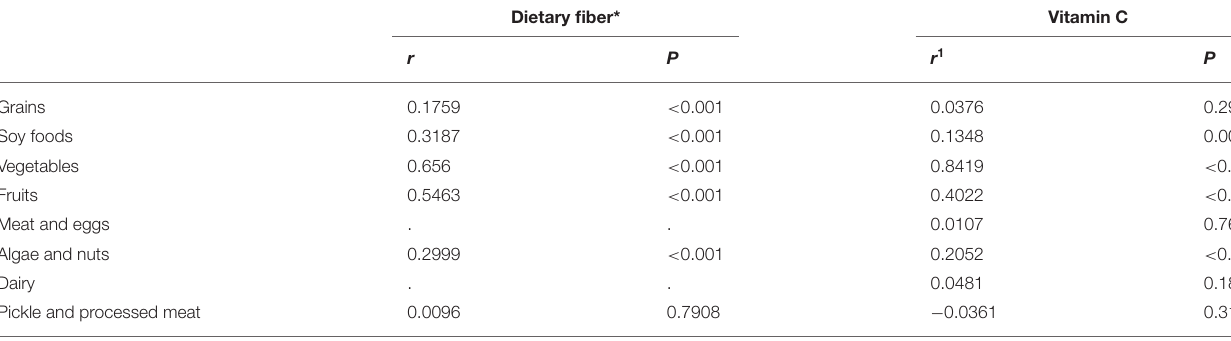
TABLE 2 | Spearman correlation coefficient between daily average intake of dietary fiber and vitamin C and food groups in all study subjects.